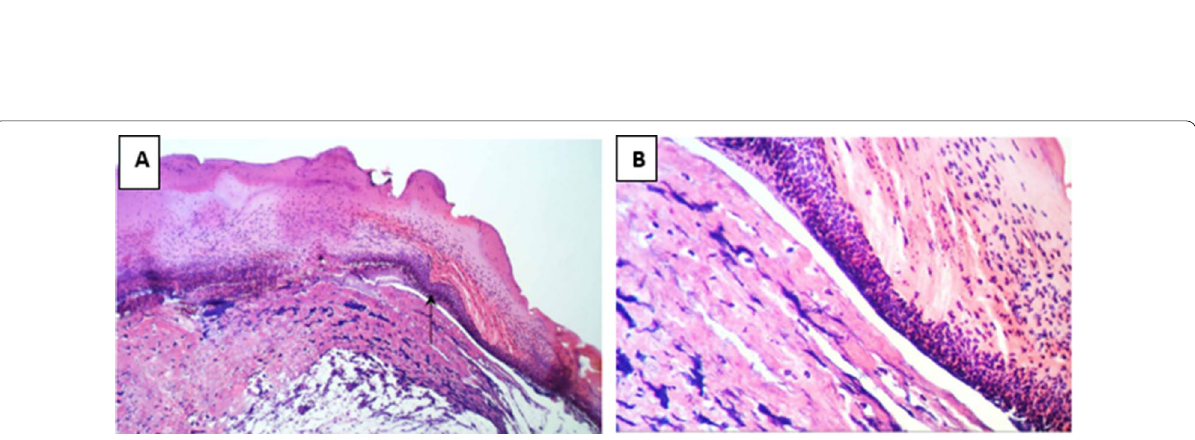
Fig. 4 A Histopathology of skin from Group C (control: burned, infected, untreated). showing wounded area with coagulative necrosis along the whole skin thickness associated with sever inflammatory cells infiltration in dermal and subcutaneous tissue associated with heavy bacterial clusters (arrow). B Higher magnification from ( A ) showing epidermal necrosis with many inflammatory cells and bacterial clusters in deeper tissue (H&E 400X)